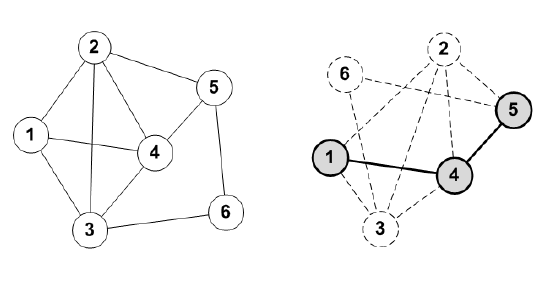
Fig. 4. Anchoring of graph